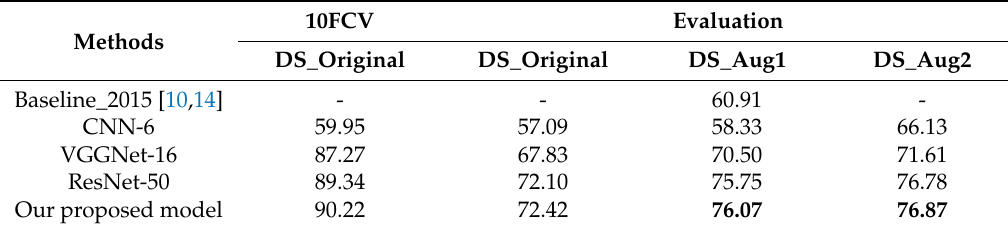
Table 1. Accuracy of visual methods in ImageCLEF2015.